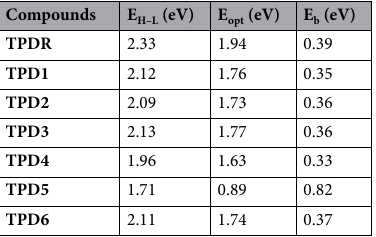
Table 6. Calculated E H − L , E opt , and E b of TPDR and TPD1 – TPD6